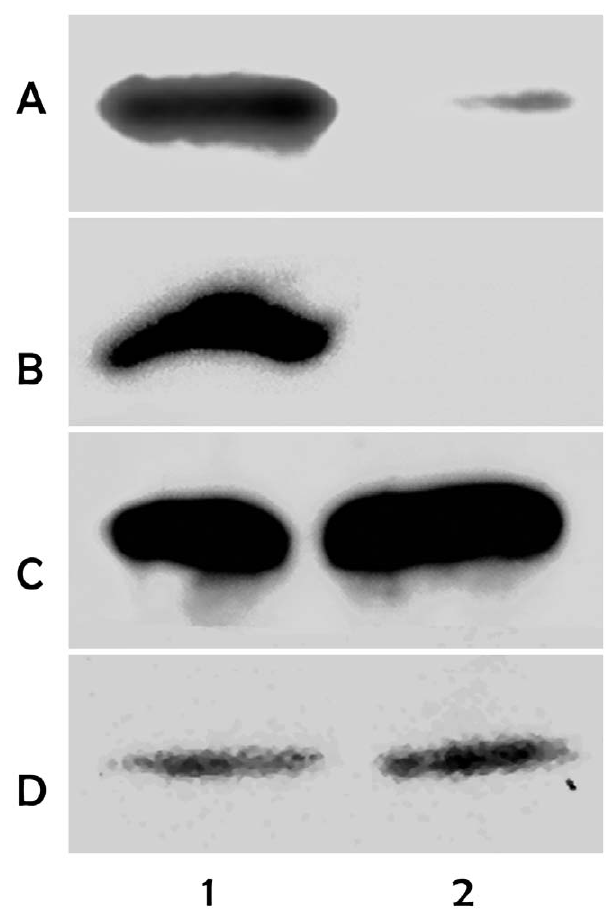
Figure 2. p26 dsRNA specifically knocks down p26 mRNA and protein in Artemia cysts. A. PCR amplification of p26 mRNA in cysts released by females injected with either control solution (1) or p26 dsRNA (2). Amplification products were resolved in 1.2% agarose gels and stained with Sybersafe. Protein from 25 cysts (B) and 40 cysts (C, D) produced by females injected with either control solution (1) or p26 dsRNA (2) were resolved in 12.5% SDS polyacrylamide gels and blotted to nitrocellulose. The blots were probed with antibody specific to p26 (B), ArHsp21 (C) and ArHsp22 (D), followed by HRP-conjugated goat anti-rabbit IgG antibody. Antibody reactive proteins were visualized by chemiluminescence.